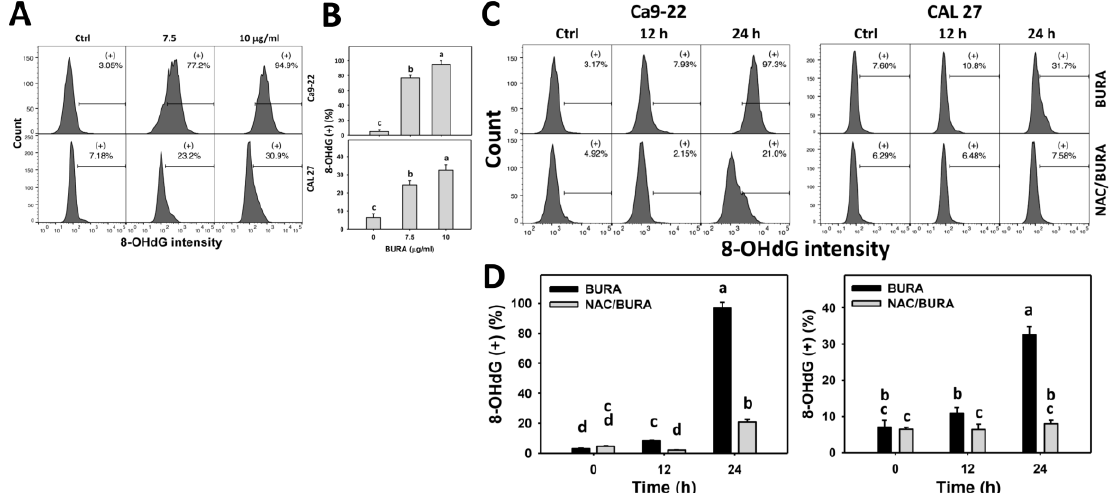
Figure 9. BURA causes 8-OHdG DNA damage in oral cancer cells. ( A , B ) 8-OHdG pattern and quantification. Oral cancer cells (Ca9-22 and CAL 27) were treated with BURA (control (0.1% DMSO), 7.5 µ g/mL (25.3 µ M), and 10 µ g/mL (33.8 µ M), 24 h). (+) located within the patterns represent 8-OHdG (+). ( C , D ) NAC effect on 8-OHdG patterns and quantification. After NAC treatment (10 mM, 1 h), cells were treated with BURA (10 µ g/mL) for 0 (control), 12 and 24 h. Data, mean ± SD ( n = 3). Data top-labeled with non-overlapping lower-case letters differ significantly according to multi-comparisons ( p < 0.05).